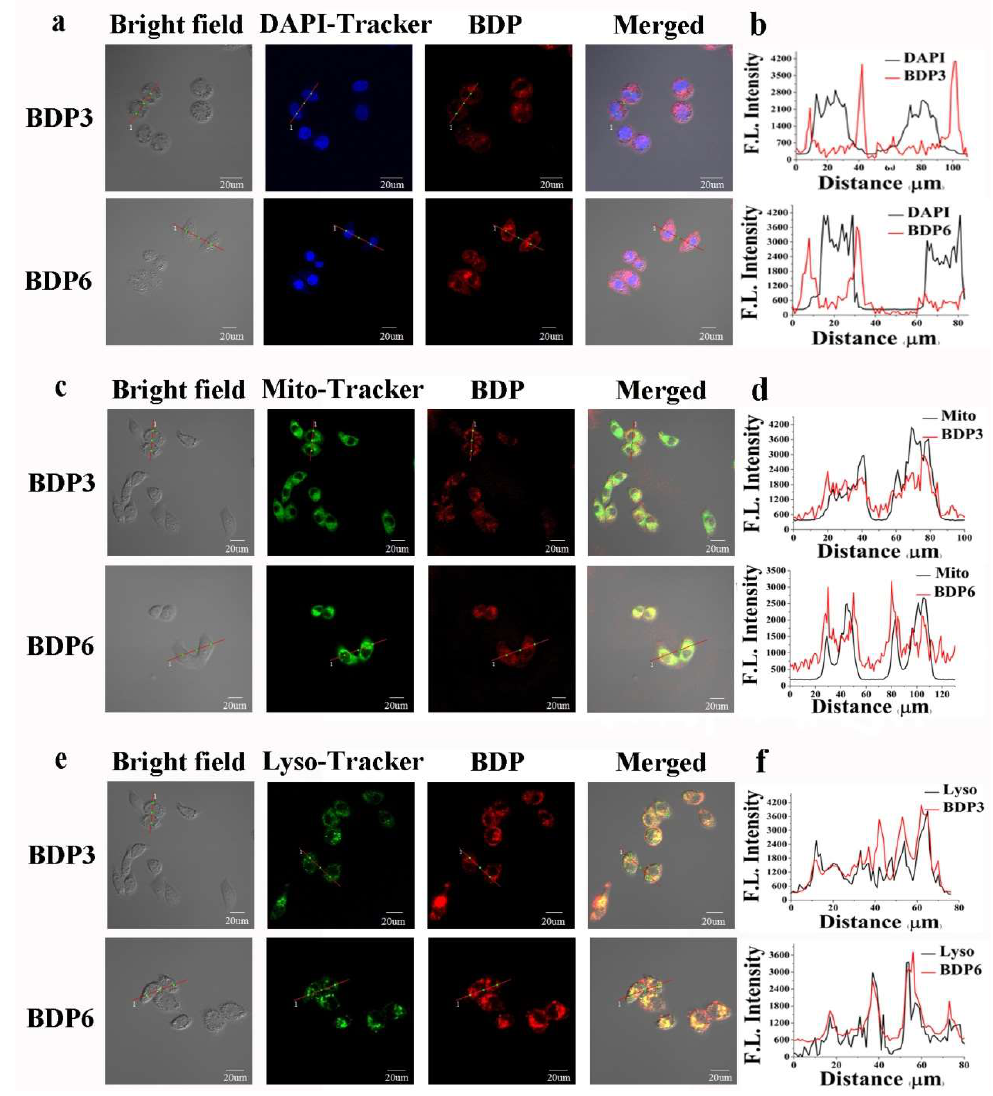
Figure 6. Visualization of the intracellular fluorescence of HepG2 cells for DAPI (in blue, a ), Mito-Tracker Green (in green, c ), Lyso-Tracker (in green, e ), and BDP3 or BDP6 (in red, 2 µ M). Fluorescence intensity profiles of DAPI ( b ), Mito-Tracker Green ( d ), Lyso-Tracker ( f ), and BDP3 or BDP6 (2 µ M) traced along the red line in ( a , c , e ).